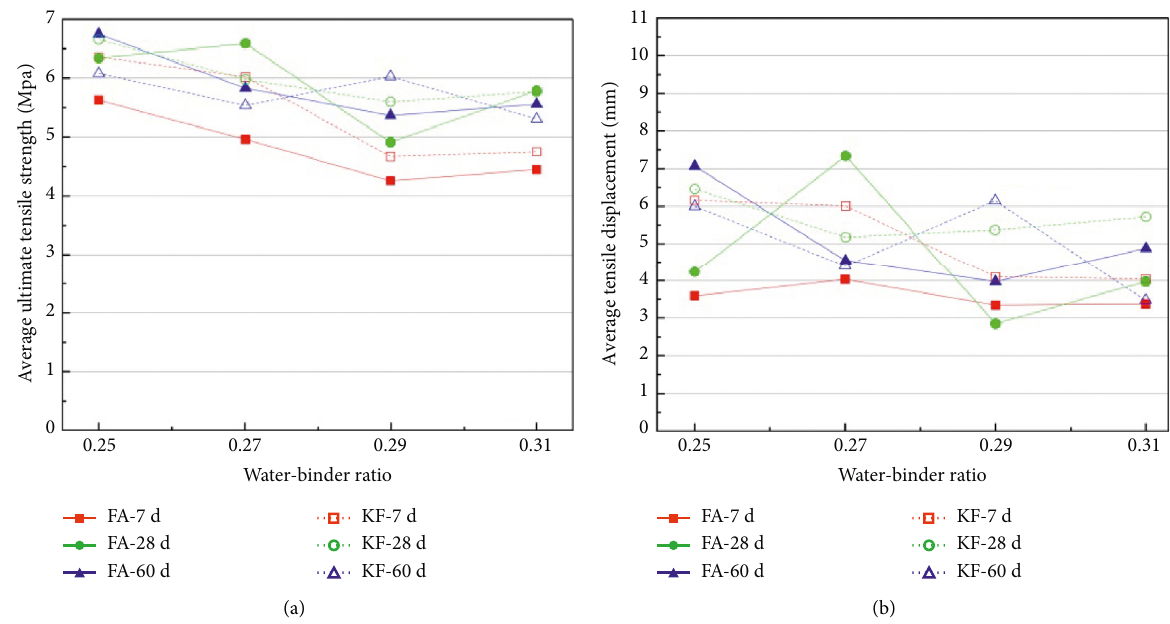
Figure 8: The effect of water-binder ratio: (a) average ultimate tensile strength, (b) average tensile